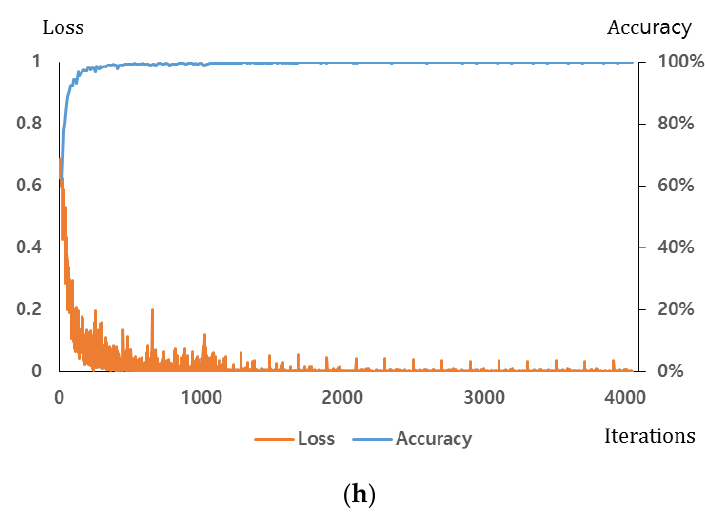
Figure 9. Loss and accuracy graphs of the training procedure: ( a ) the 1st fold (visible light candidate images); ( b ) the 1st fold (FIR candidate image); ( c ) the 2nd fold (visible light candidate images); ( d ) the 2nd fold (FIR candidate image); ( e ) the 3rd fold (visible light candidate images); ( f ) the 3rd fold (FIR candidate image); ( g ) the 4th fold (visible light candidate images); ( h ) the 4th fold (FIR candidate image).